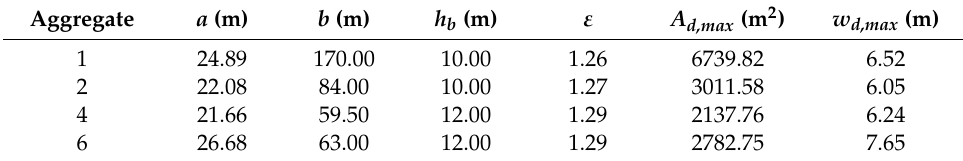
Figure 7. Road segments and structural aggregates in “Corso Umberto I” according to the limiting conditions of the emergency (LCE) analysis of the municipality of Amatrice [22]. Table 2. The areas and widths of the debris for the considered structural aggregates.